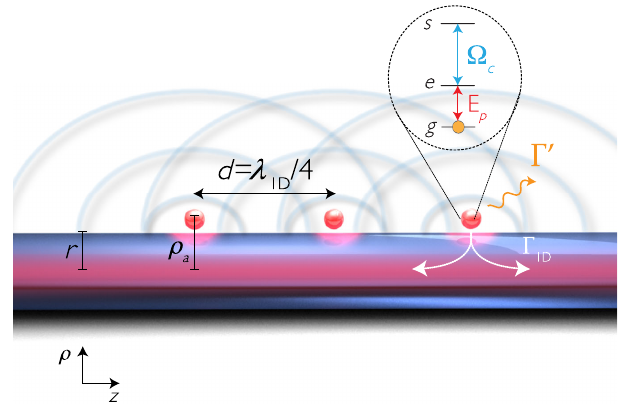
FIG. 13. Electromagnetically induced transparency scheme. The j g i to j e i transition is coupled to the guided mode, and the j s i to j e i transition is driven by an external, classical control field of Rabi frequency Ω . The distance between the atoms is a c = 4 quarter of the guided-mode wavelength, d ¼ λ 1 D